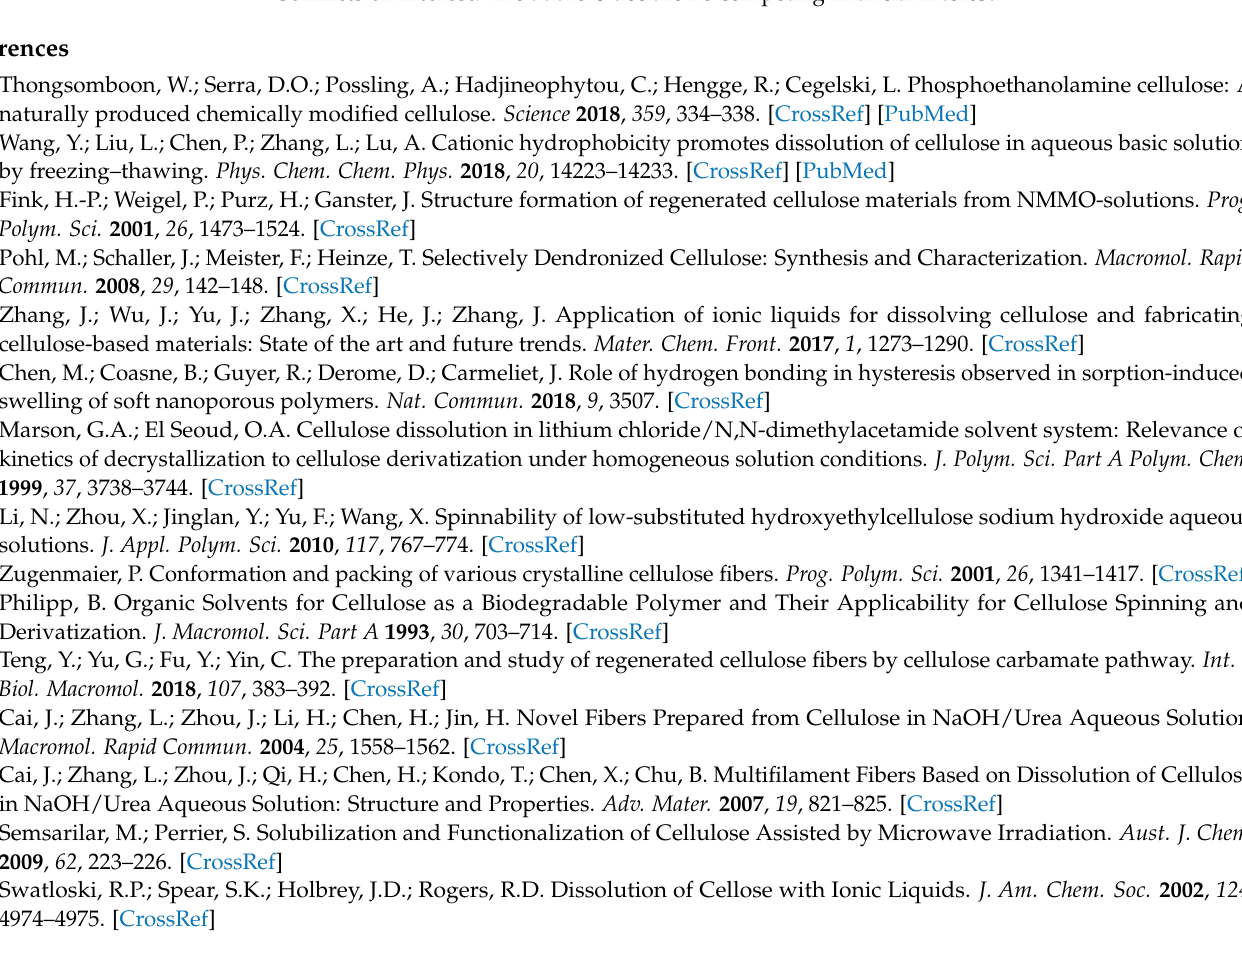
tions; Figure S1: Solubility of CC in NaOH/ZnO aqueous solutions with various NaOH and ZnO contents, Figure S2: XRD pattern of the crystals precipitated out from 7 wt% NaOH/2 wt% ZnO and CC/7 wt% NaOH/2 wt% ZnO aqueous solution over the storage time at room temperature, Figure S3: The melting enthalpies of 5 wt% CC in 7 wt% NaOH and 7 wt% NaOH/1.6 wt% ZnO aqueous solu- tions during the 1st and 2nd cooling/heating processes (20 ◦ C~ − 40 ◦ C~20 ◦ C),Figure S4: Magnified DSC heating thermograms of CC (1, 3 and 5 wt%) in (a) 7 wt% NaOH and (b) 7 wt% NaOH/1.6 wt% ZnO aqueous solutions; (c) the corresponding melting enthalpies of the CC solutions, Figure S5: The hydrodynamic radius (Rh) of CC in NaOH/ZnO aqueous solutions with various NaOH and ZnO contents were calculated from the CONTIN